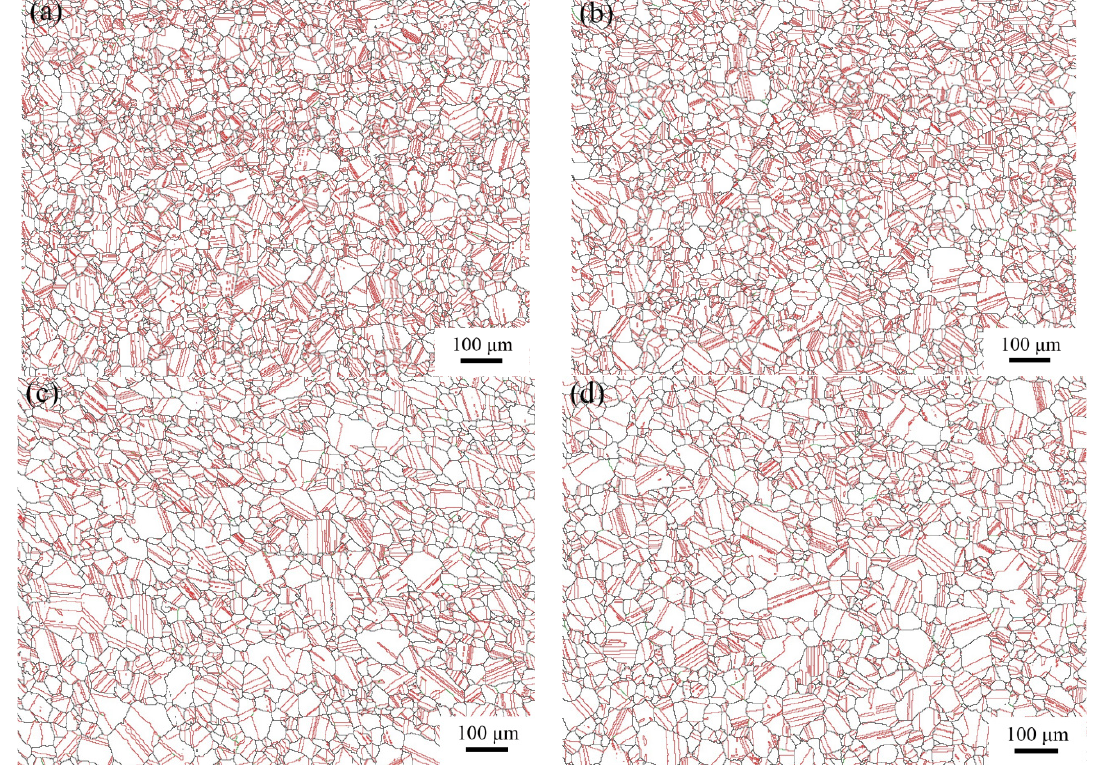
Figure 9. Grain boundary maps of Ni-36.6W-15Co after annealing for ( a ) 10 min, ( b ) 30 min, ( c ) 60 min and ( d ) 120 min at 1150 °C.